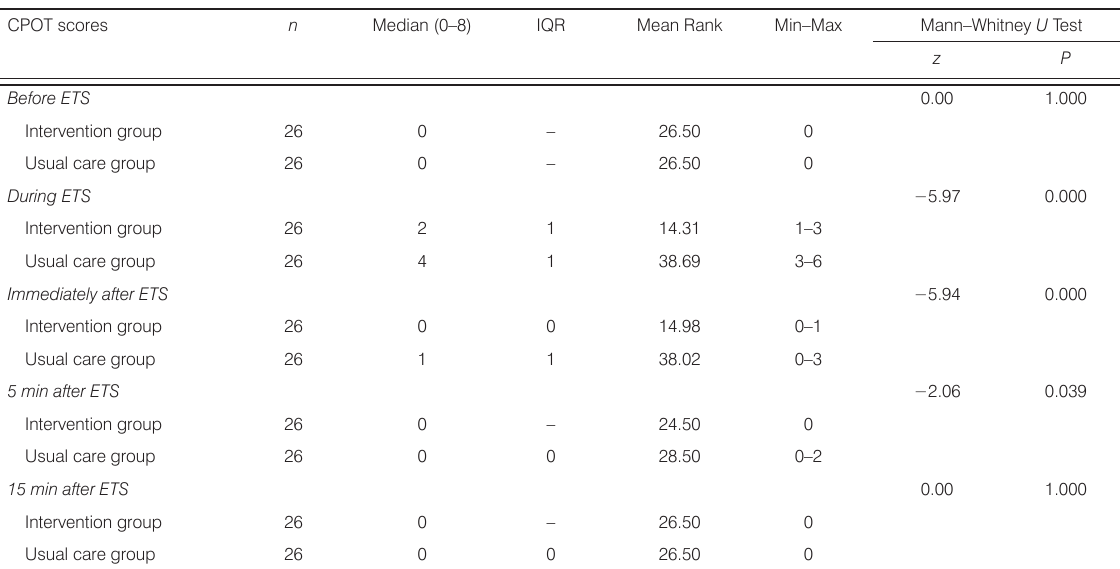
Table 1. Level of Pain Presence (CPOT Scores) of the Study Participants in the Control and Intervention Groups ( N =